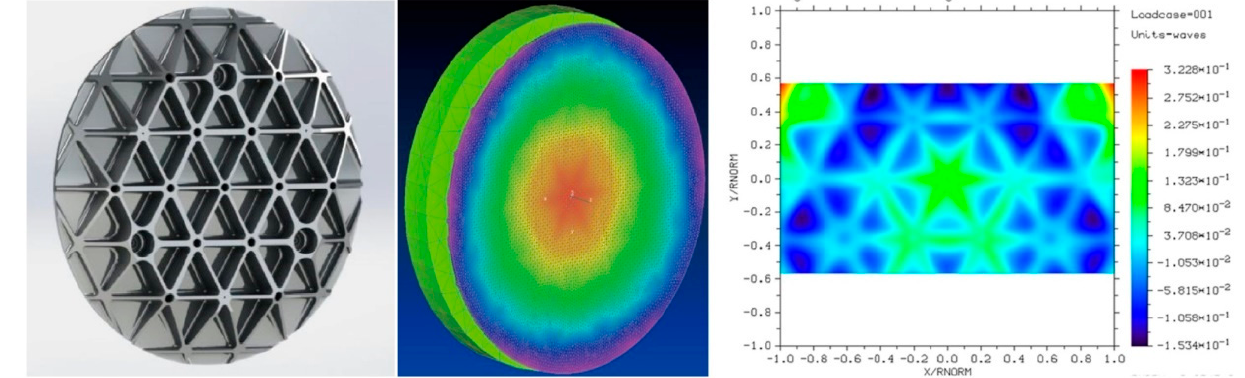
Figure 36. FEA of print-through due to diamond turning fling [17].